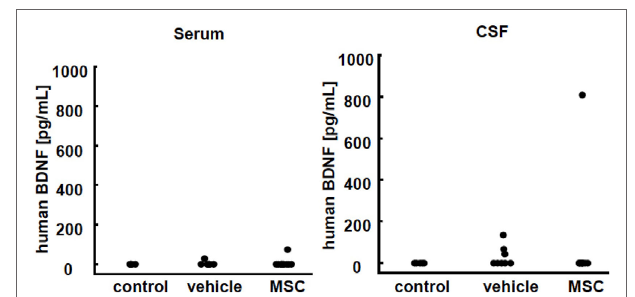
FigUre 6 | Human brain-derived neurotrophic factor (BDNF) detection in serum and cerebrospinal fluid (CSF) 24 h after injection. No BDNF was detected in the control group. Only one of the 13 mice treated with umbilical cord-derived MSCs showed elevated human BDNF levels in CSF. Some mice in the vehicle group showed a minimal equivocal level of BDNF (control n = 6, vehicle n = 6, and UC-MSC n =